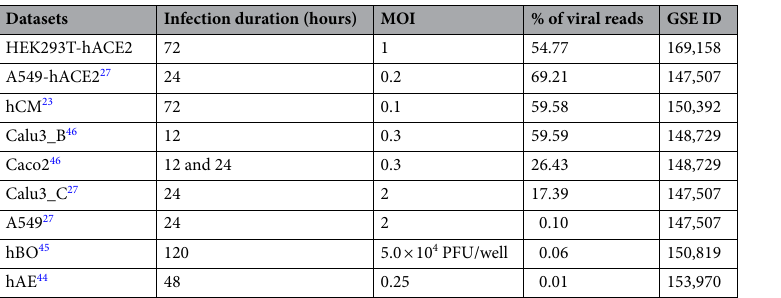
Table 1. RNAseq datasets from GEO